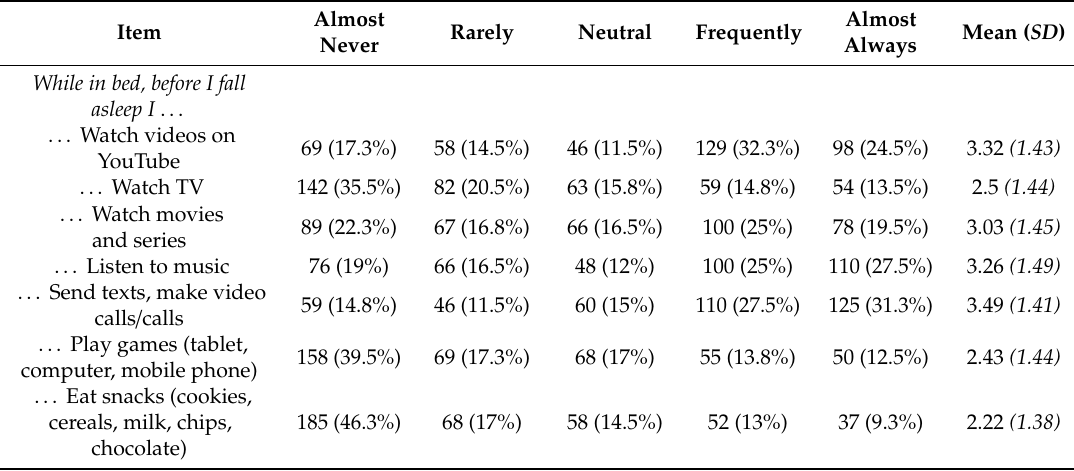
Table 2. While-in-Bed Procrastination Scale